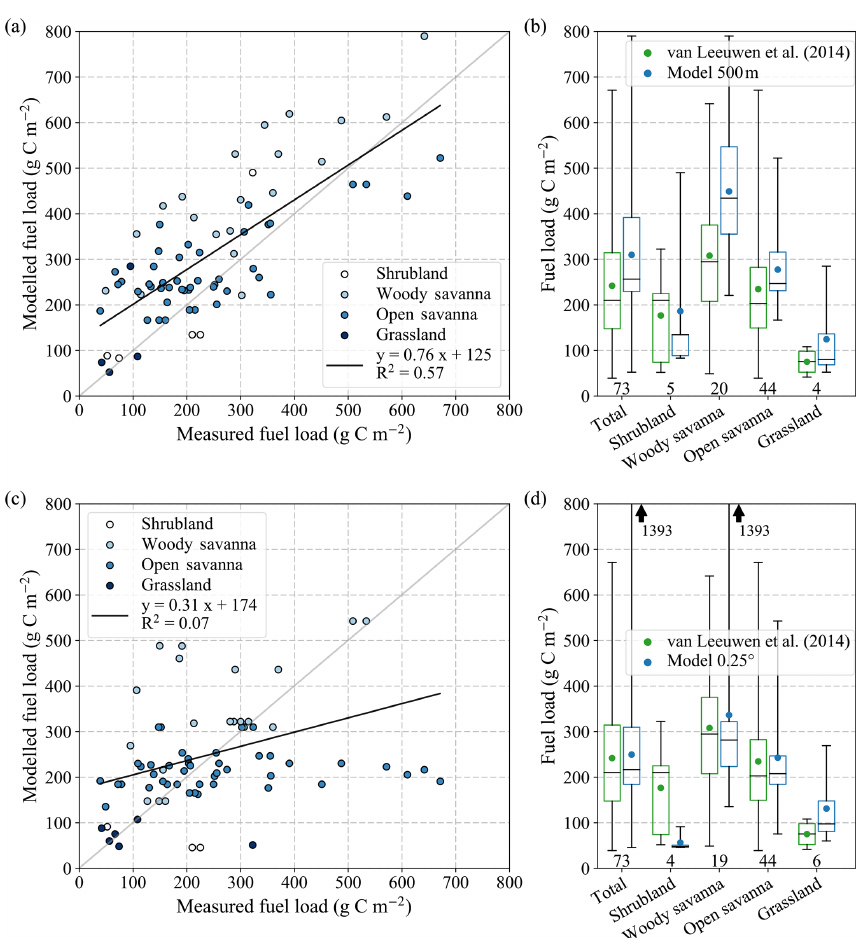
Figure 5. Comparison of modelled FL at and field measurements based on calibration for 0.25 ◦ resolution, shown as scatter plot and boxplots per biome for (a, b) 500m resolution and (c, d) 0.25 ◦ resolution simulations. The boxplot description is equivalent to Fig. 2. Black triangles depict whiskers outside the plot